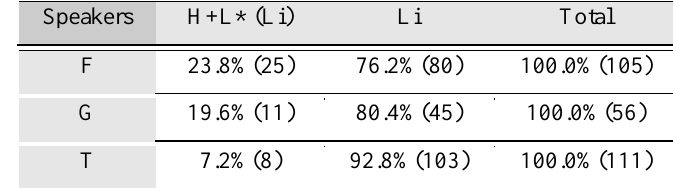
Table VIII. Tonal events associated with the final contour of the sentences with narrow-focus on the